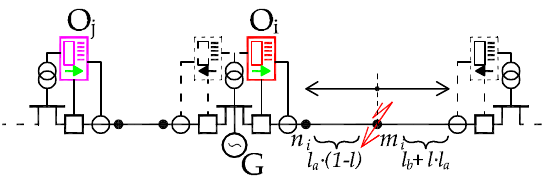
Figure 10. Coordinated IEEE 6-bus power system.